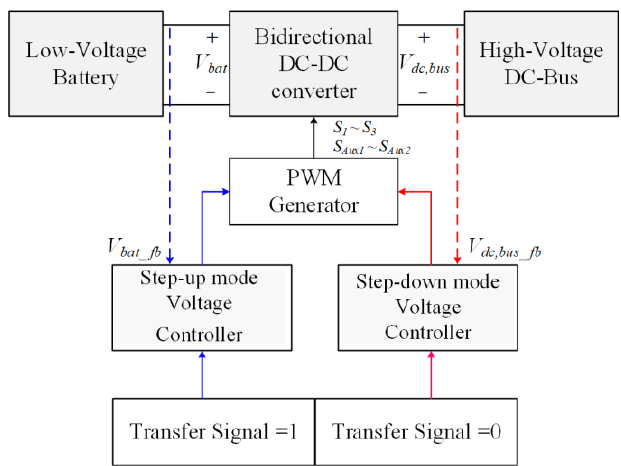
Figure 13. Block diagram of the control strategy.